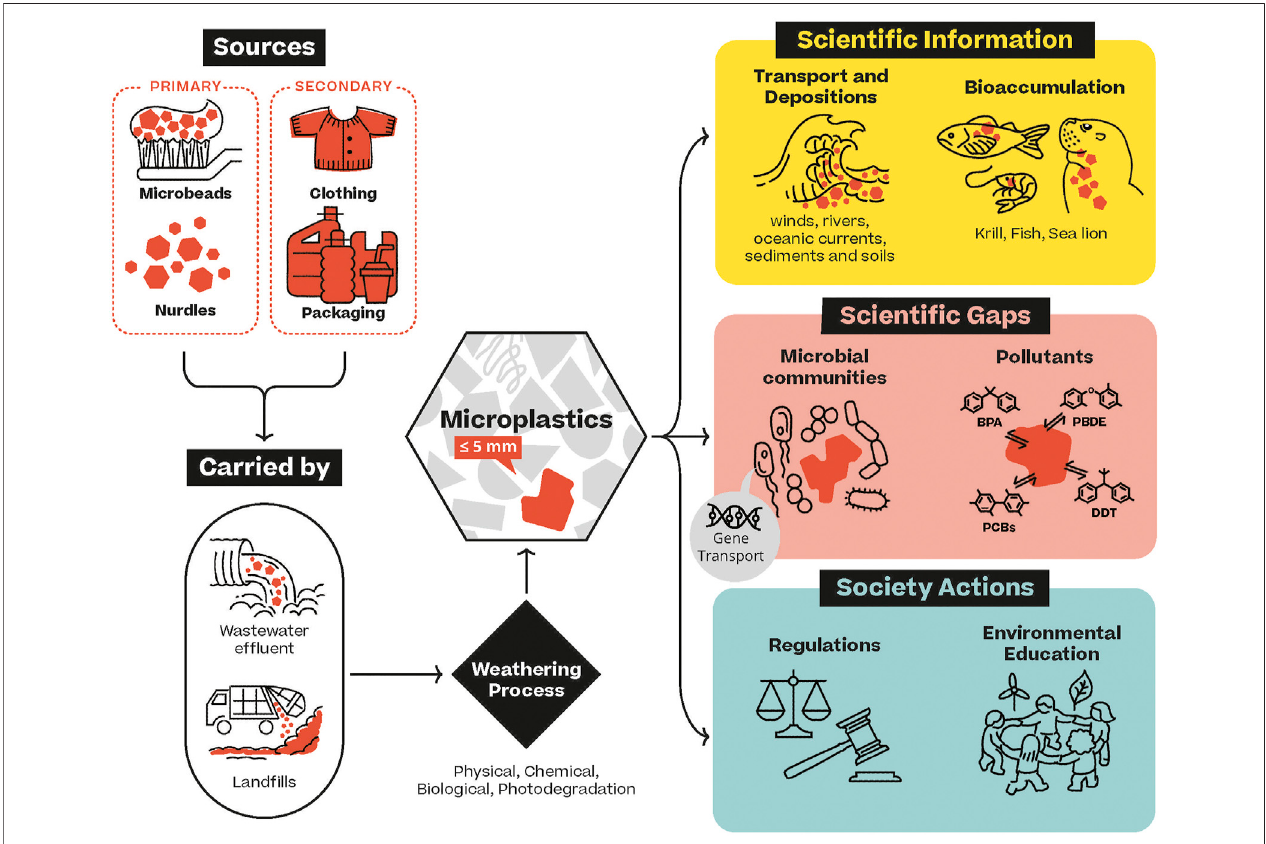
FIGURE2| Overallsourcesandtransportofmicroplastic,andthecurrentexitingeffortsinChileaboutmicroplasticpollutionincludingresearch,scienti fi cgapsand society action.